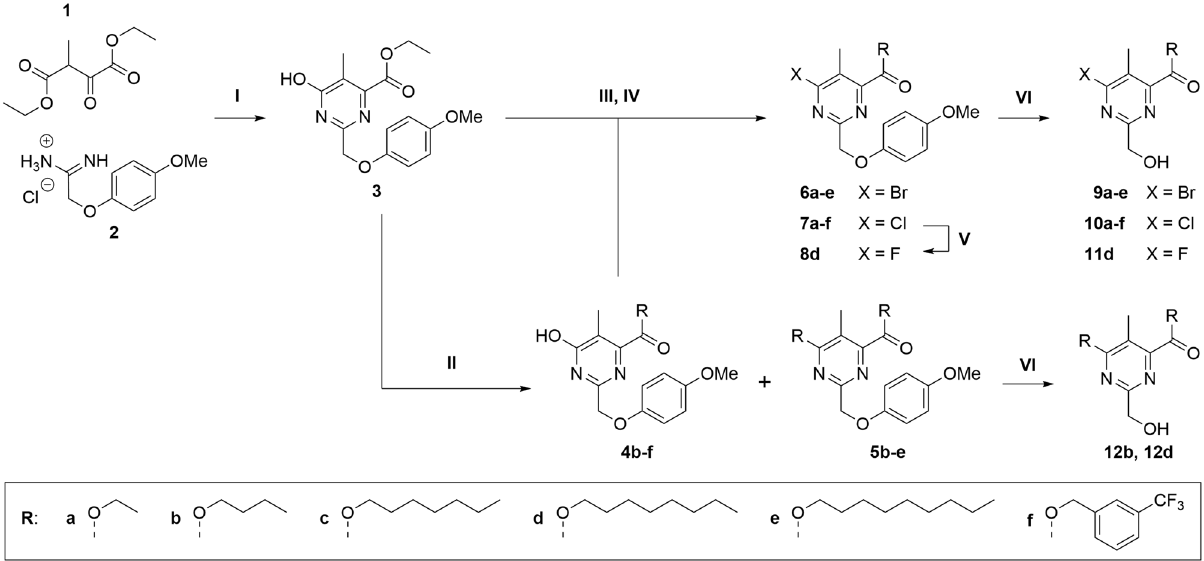
Figure 2. Synthesis and derivatization routes of sets I and II of 2,4,5,6-tetrasubstituted pyrimidines. Conditions: (I) TEA, EtOH, reflux, 2.5 h, 31%; (II) alcohol, H 2 SO 4 (cat.), 100 °C, 3–48 h, 18–58%; (III) POBr 3 , DMF, MW